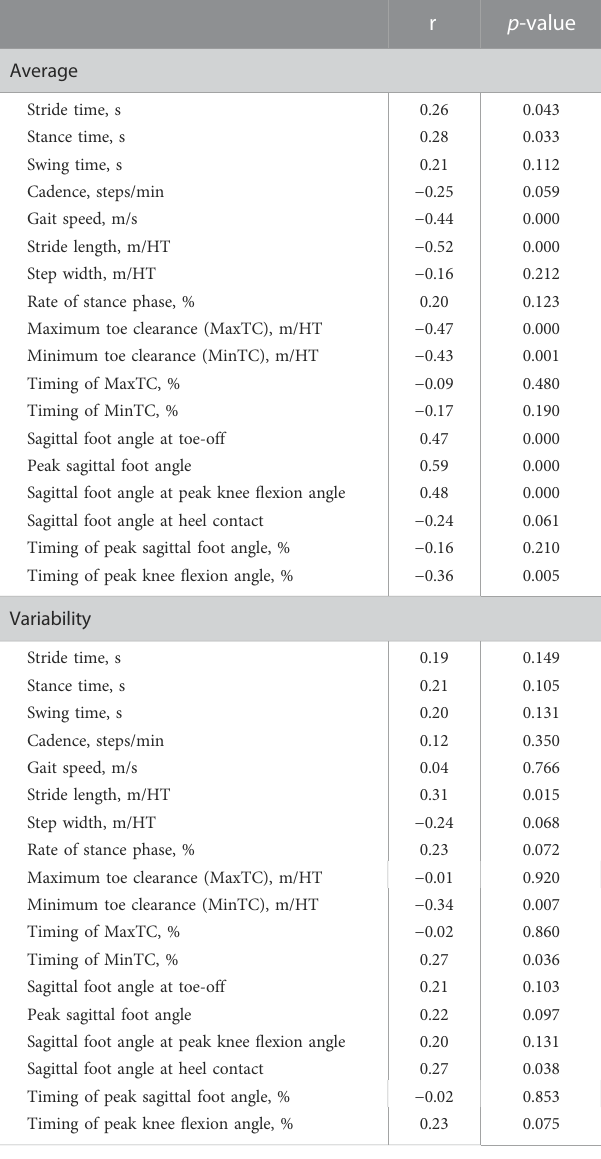
TABLE 5 Results for correleation coef fi cients between gait parameters and